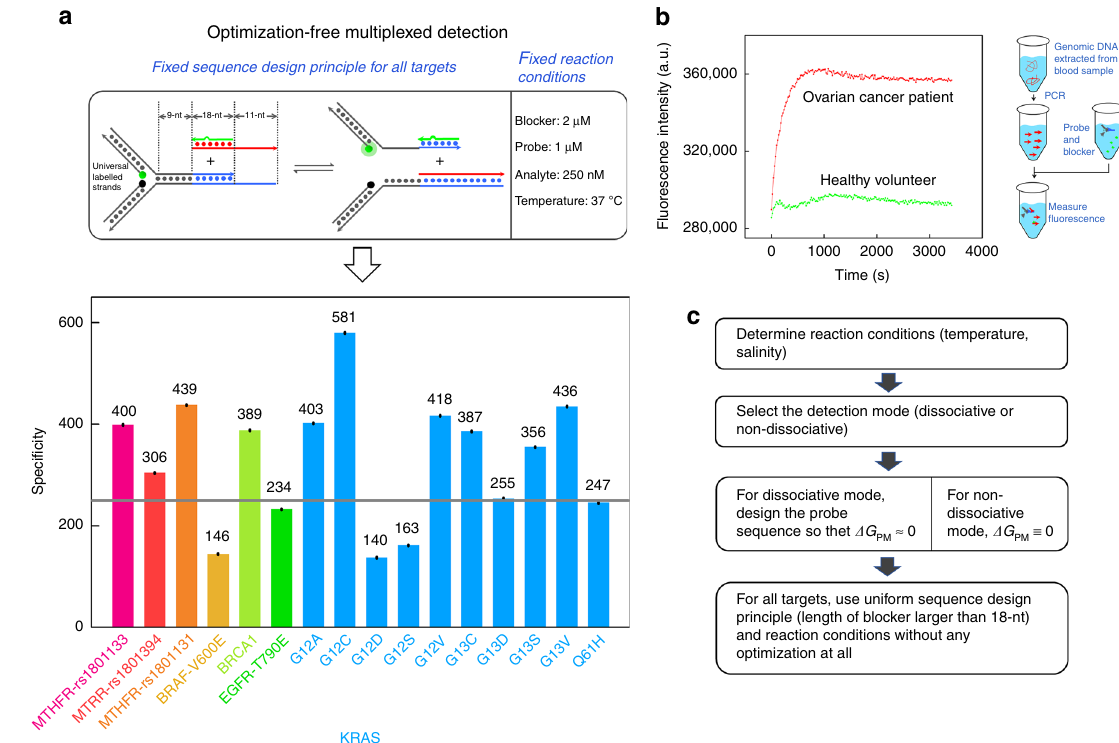
Fig. 5 Multiplexed detection by the 4-way SELECT system. a Optimization-free multiplexed detection of 16 kinds of genetic variations. The fl uorophore and quencher of the probe was designed to be universal, and the sequence design principle and reaction conditions were fi xed to be exactly the same towards all targets. b Post-PCR genotyping using the universal 4-way SELECT system. c The work fl ow for designing a 4-way SELECT system. Source data